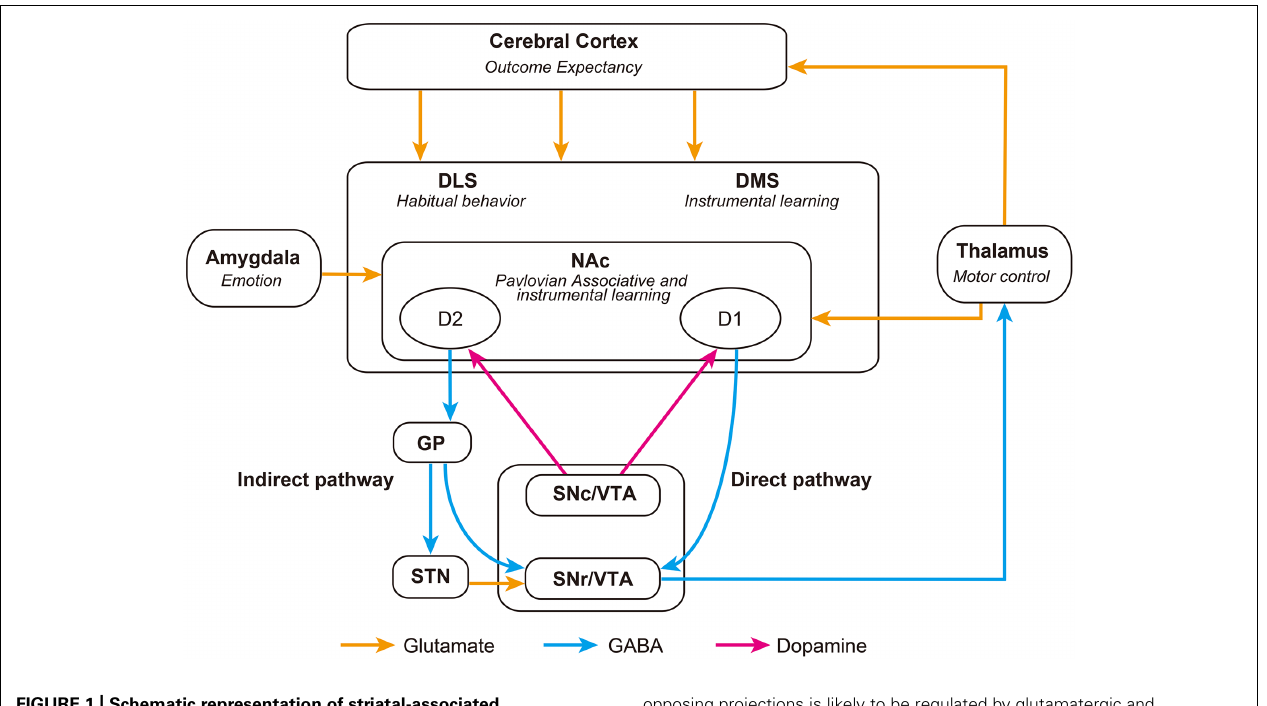
FIGURE 1 | Schematic representation of striatal-associated decision-making neurocircuitry. Striatonigral D1 direct pathway neurons inhibit the SNr and release inhibition of thalamic activity, promoting behavior. Whereas, striatonigral D2 indirect pathway neurons inhibit the GP, disinhibiting the STN and exciting the SNr, which ultimately inhibits the thalamus and thus suppresses behavior.The balance between these